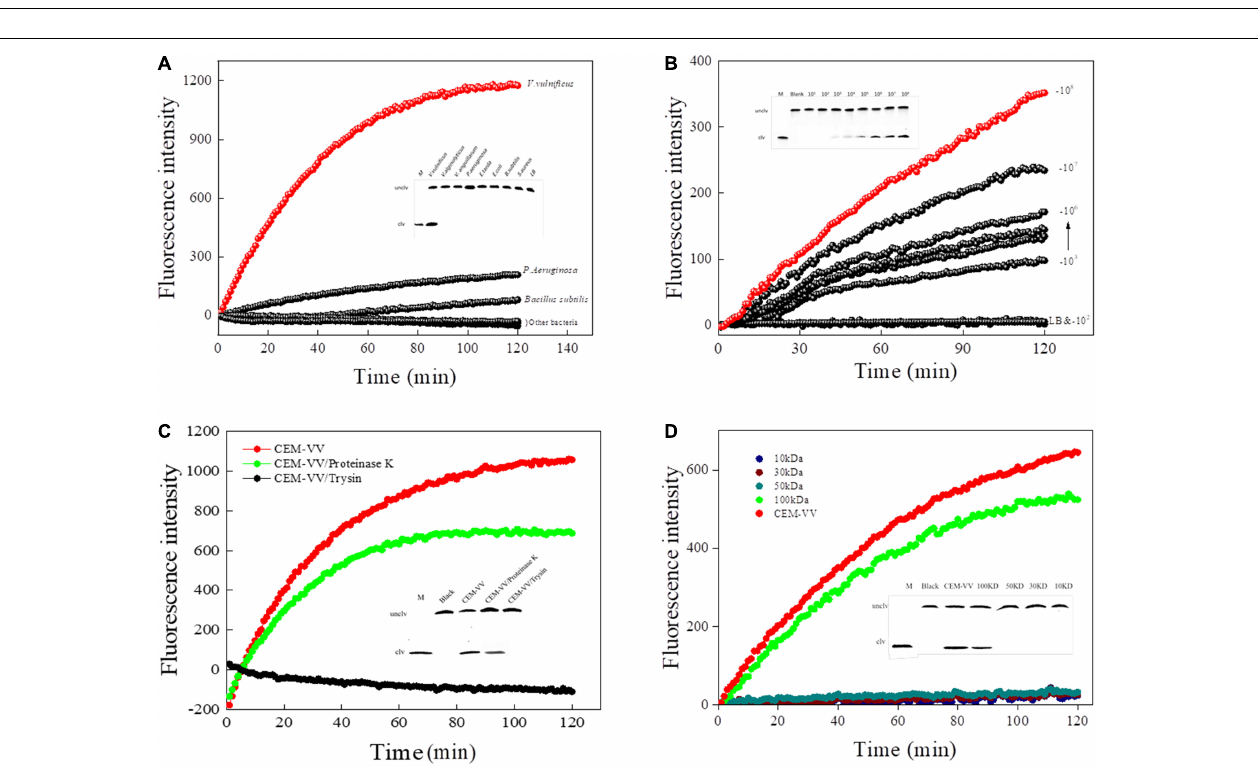
FIGURE 6 | (A) The biosensor-based assay responded to RFD-VV-M2 in a blank culture medium and seven bacteria. Inset: Cleaving gel image for RFD-VV-M2 specificity detection within 1 h. (B) Biosensor assay of RFD-VV-M2 using CEM-VV from different concentrations of V. vulnificus . Inset: Gel micrograph showing the activity for 1 h. (C) The RFD-VV-M2-based biosensor exhibited no signal in response to trypsin-treated CEM-VV. Inset: Gel micrograph showing the biosensor activity. (D) Assessment of the molecular weight of the target protein. Inset: Gel images of the response to different molecular weight samples; all the cleavage reactions were conducted in buffer B for 1